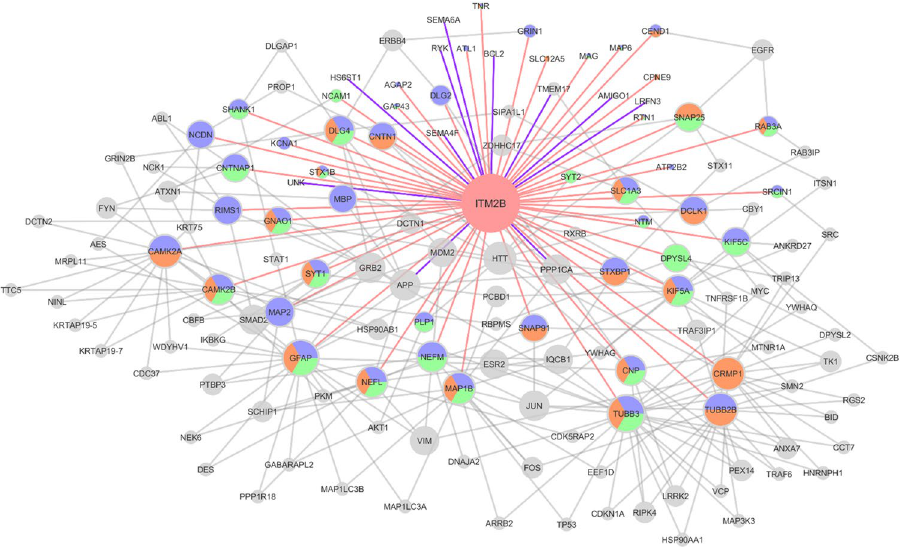
Figure 3. BRI2 brain ES sub-network for neuronal differentiation annotated proteins. Node colors represent the source of the protein: blue nodes correspond to proteins identified in this study in the cerebral cortex, orange nodes correspond to proteins identified in this study in the hippocampus, green nodes correspond to proteins identified in this study in the cerebellum, and grey nodes are proteins added by network augmentation. Node size according to the degree in the network. Edge color represents the source of interaction: light red edges correspond to the novel BRI2 interactions identified in our study, whereas the grey edges correspond to interactions added by network